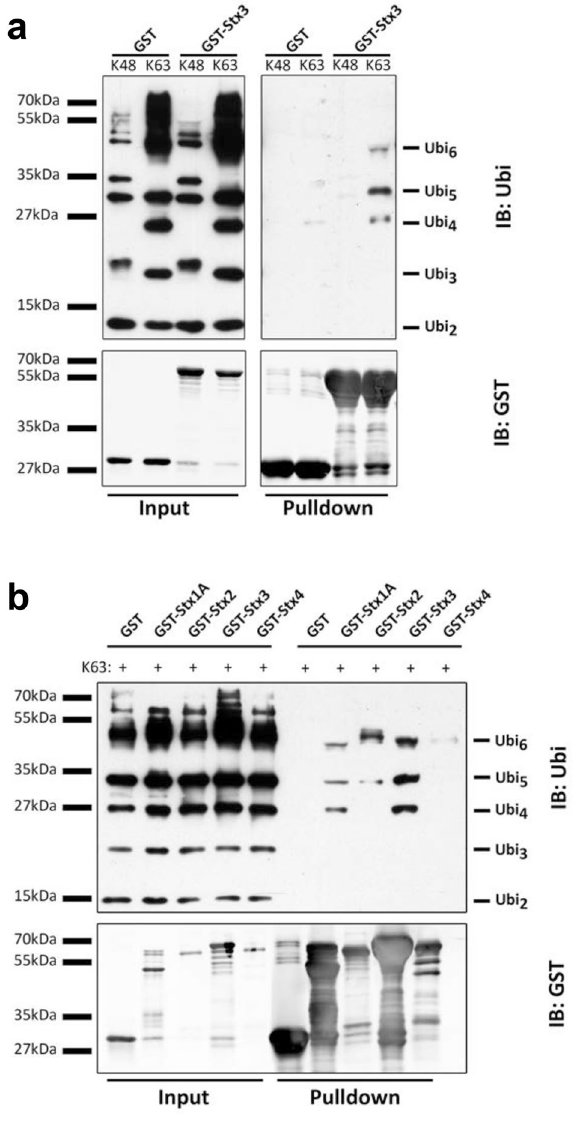
Figure 2. Stx3 binding to K63-linked polyubiquitin chains. ( A ) Purified GST fusion protein of Stx3 (cytoplasmic region, 1–265) was incubated with a mix of K48 or K63-linked polyubiquitin chains (2–7 ubiquitin molecules in length) followed by pull-down with glutathione sepharose and immunoblot (IB) using anti- ubiquitin or anti-GST antibodies. ( B ) Purified GST fusion protein of the cytoplasmic regions of Stx1A, Stx2, Stx3, or Stx4 were incubated with a mix of K63-linked polyubiquitin chains (2–7 ubiquitin molecules in length) followed by glutathione sepharose pull-down and probed with anti-ubiquitin and anti-GST antibodies. In A and B, experiments shown are representative of three independent